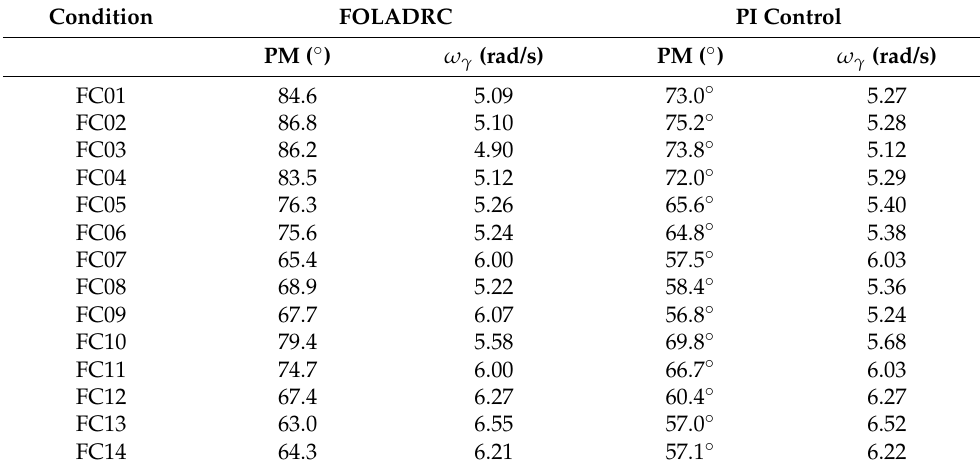
Table 1. Phase margin comparison.